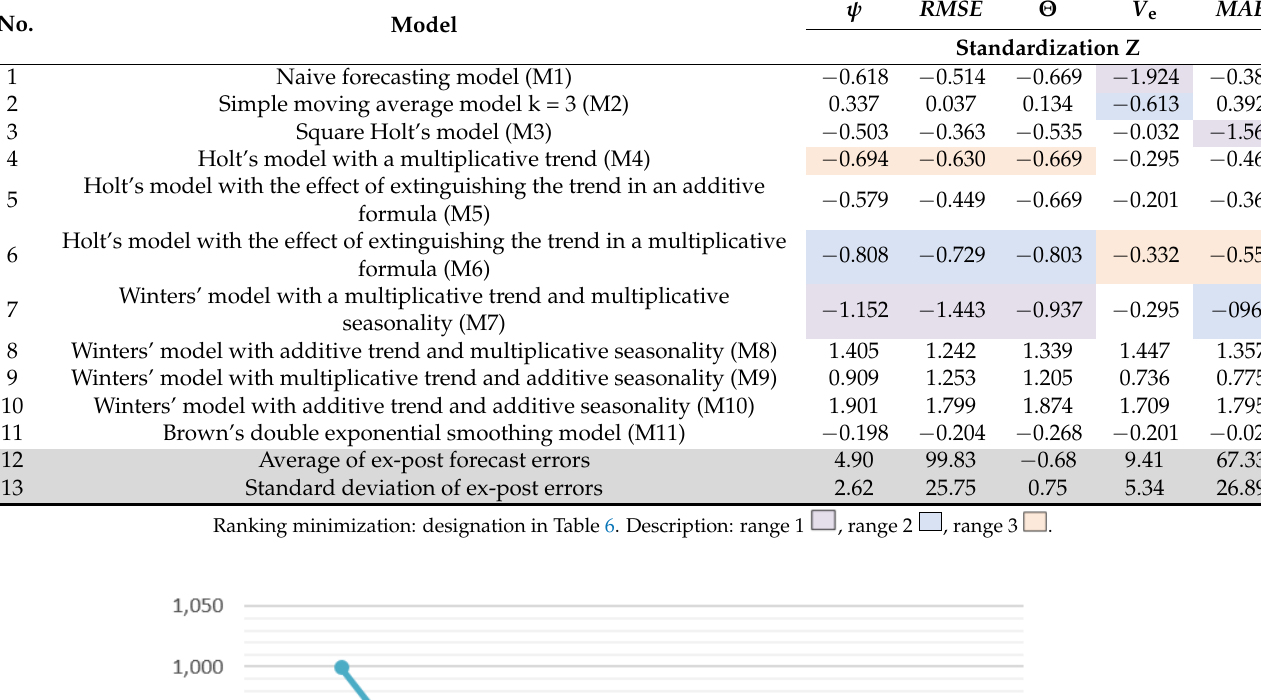
Table 6. Standardization of ex post forecast errors for the number of participants in accidents in the steel sector in Poland (own study).